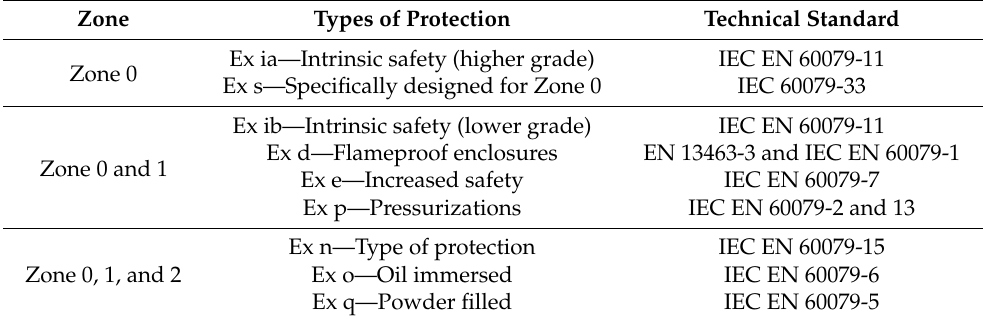
Table 4. Examples of types of protection for a certain Zone